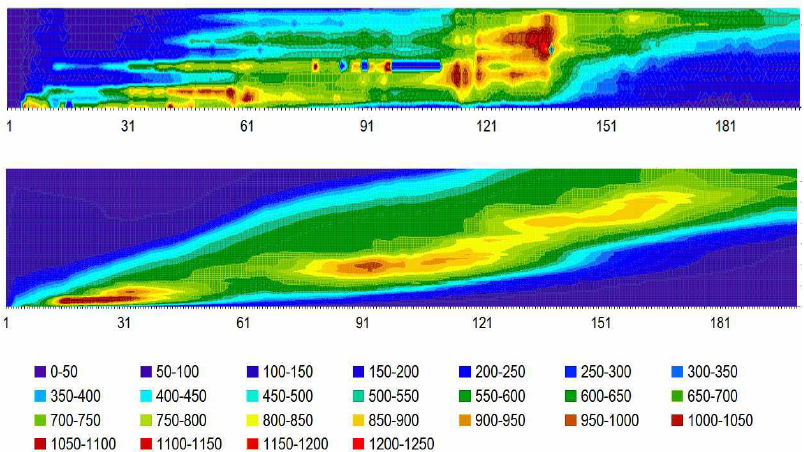
Figure 3. Development of temperatures after the cross section of the generator in time and in laboratory conditions, 1–181 time in hours. The perpendicular axis shows the length of the generator, 0.3 m to 2.6 m [33].